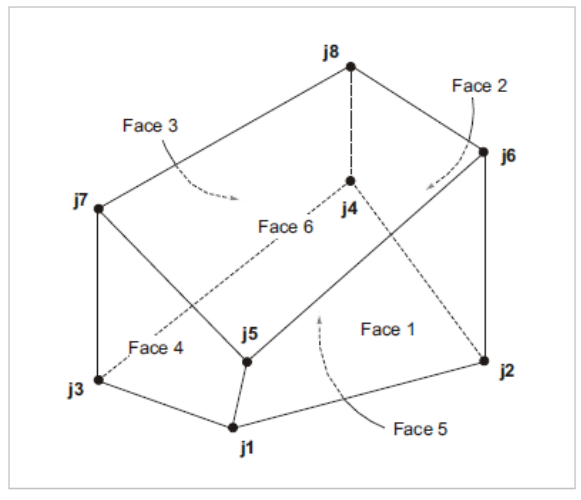
Figure 5: Sap2000 (cid:114) : Eight-node SOLID